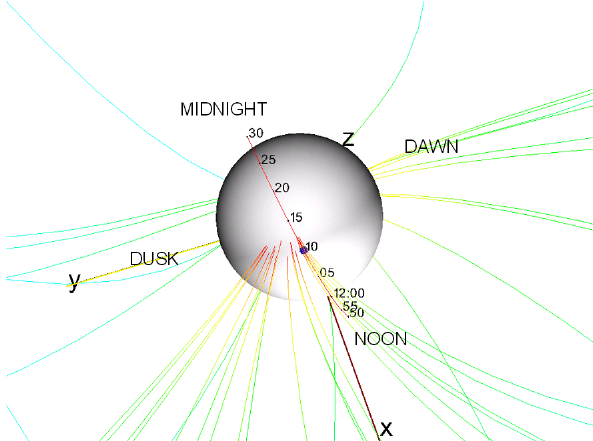
Fig. 15. The trajectory of TC-2 near perigee in the SM system on 14 September 2004 (11:50:00–12:30:00 UT) plotted using OVT soft- ware (http://ovt.irf.use). Tick marks are provided every 5min. The position of the spacecraft at 12:10 UT is indicated by a blue cir- cle. The magnetic field lines follow the model of Tsyganenko et al.